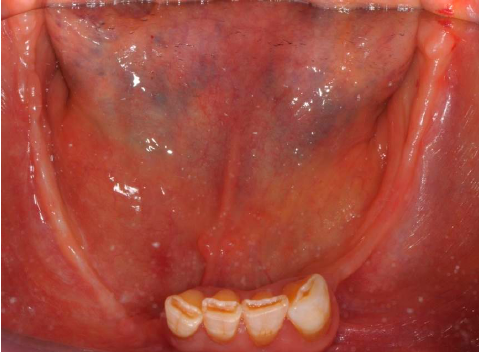
Figure 10. October 2016 follow-up visit: the oral mucosa showed no dehiscence in the areas of extractions and no other symptoms occurred.